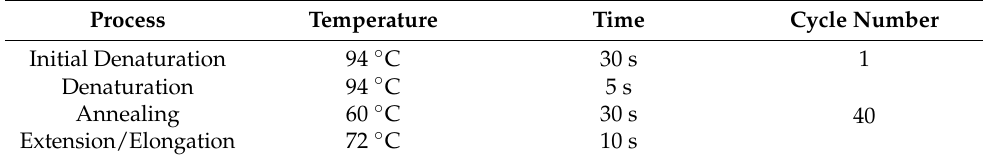
Table 2. The procedure of real-time PCR.